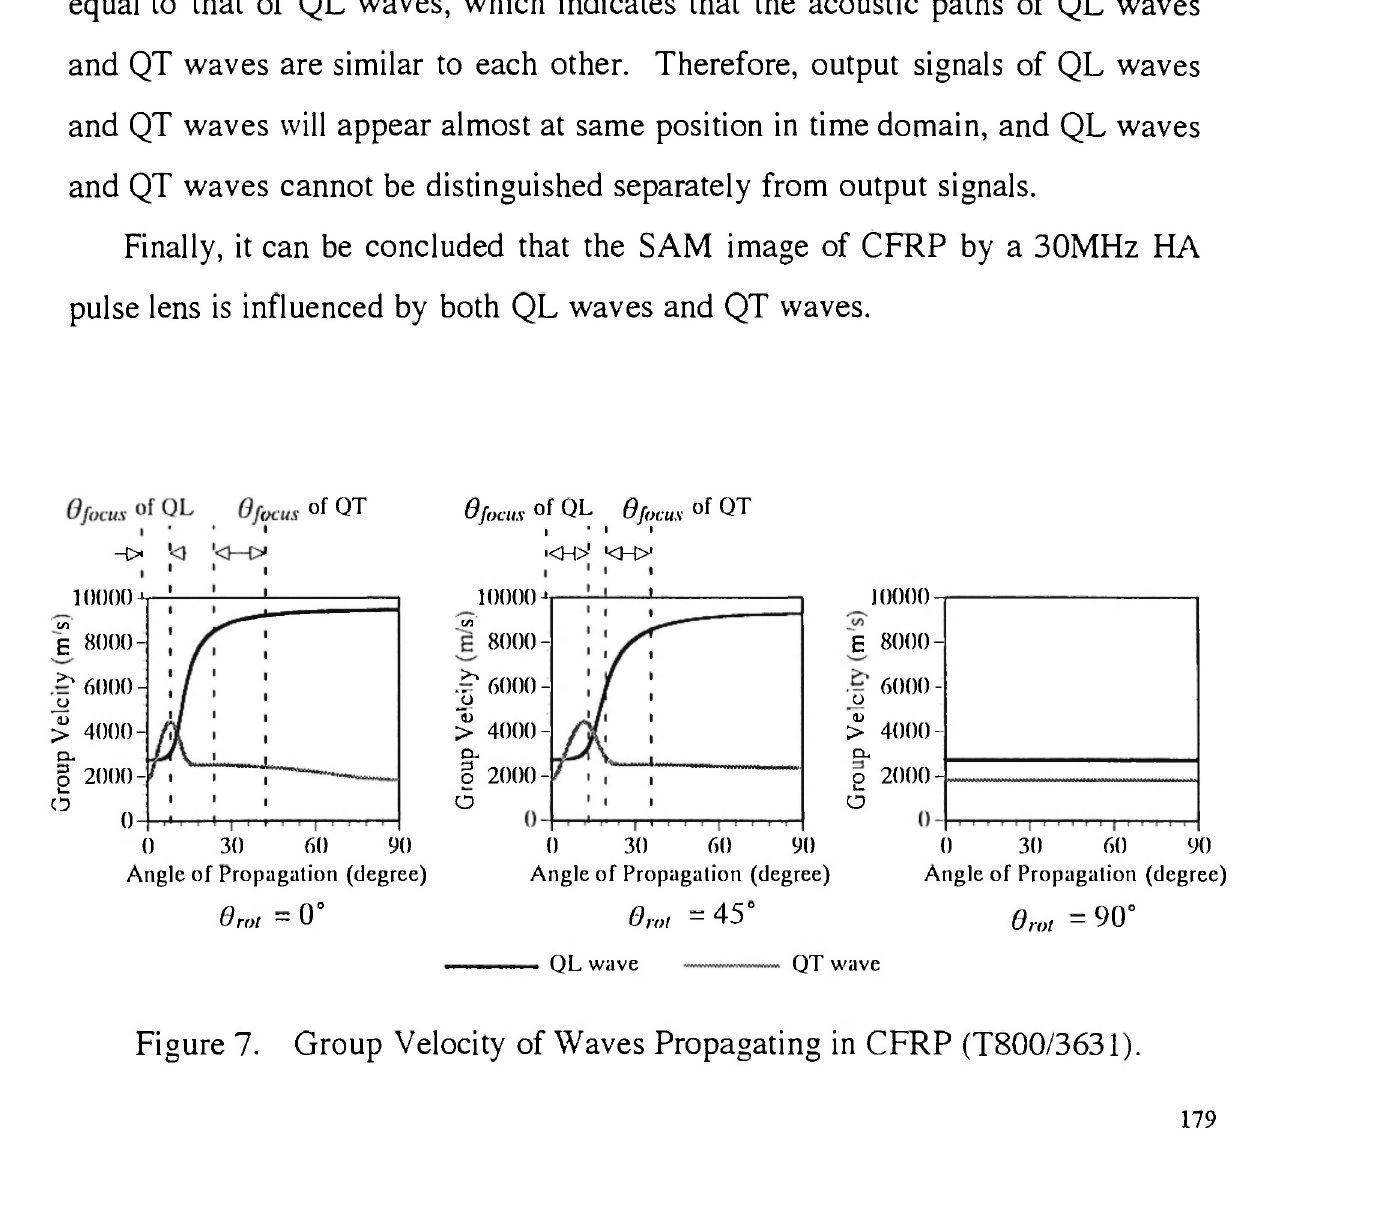
Figure 7. Group Velocity of Waves Propagating in CFRP